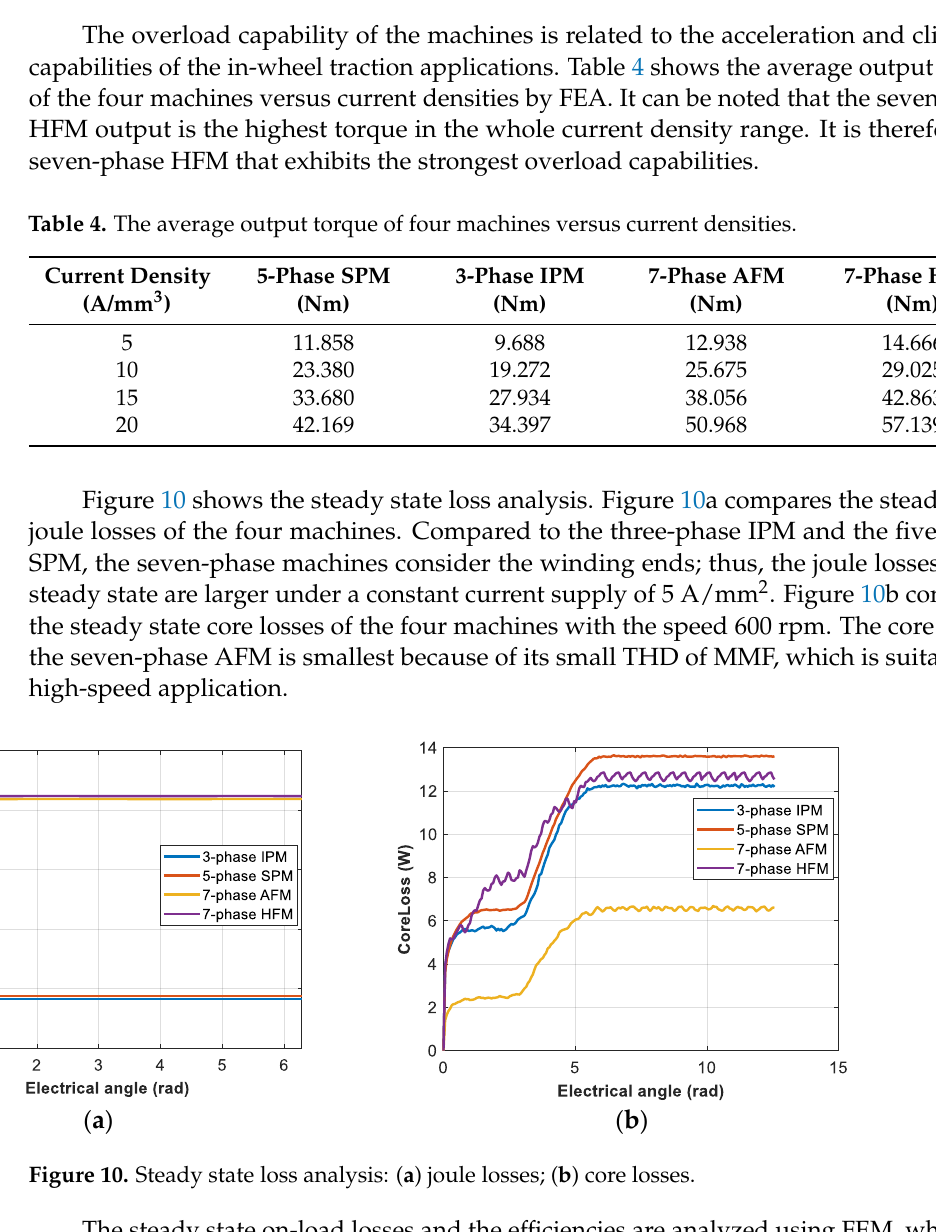
Table 5. Efficiency of four machines.